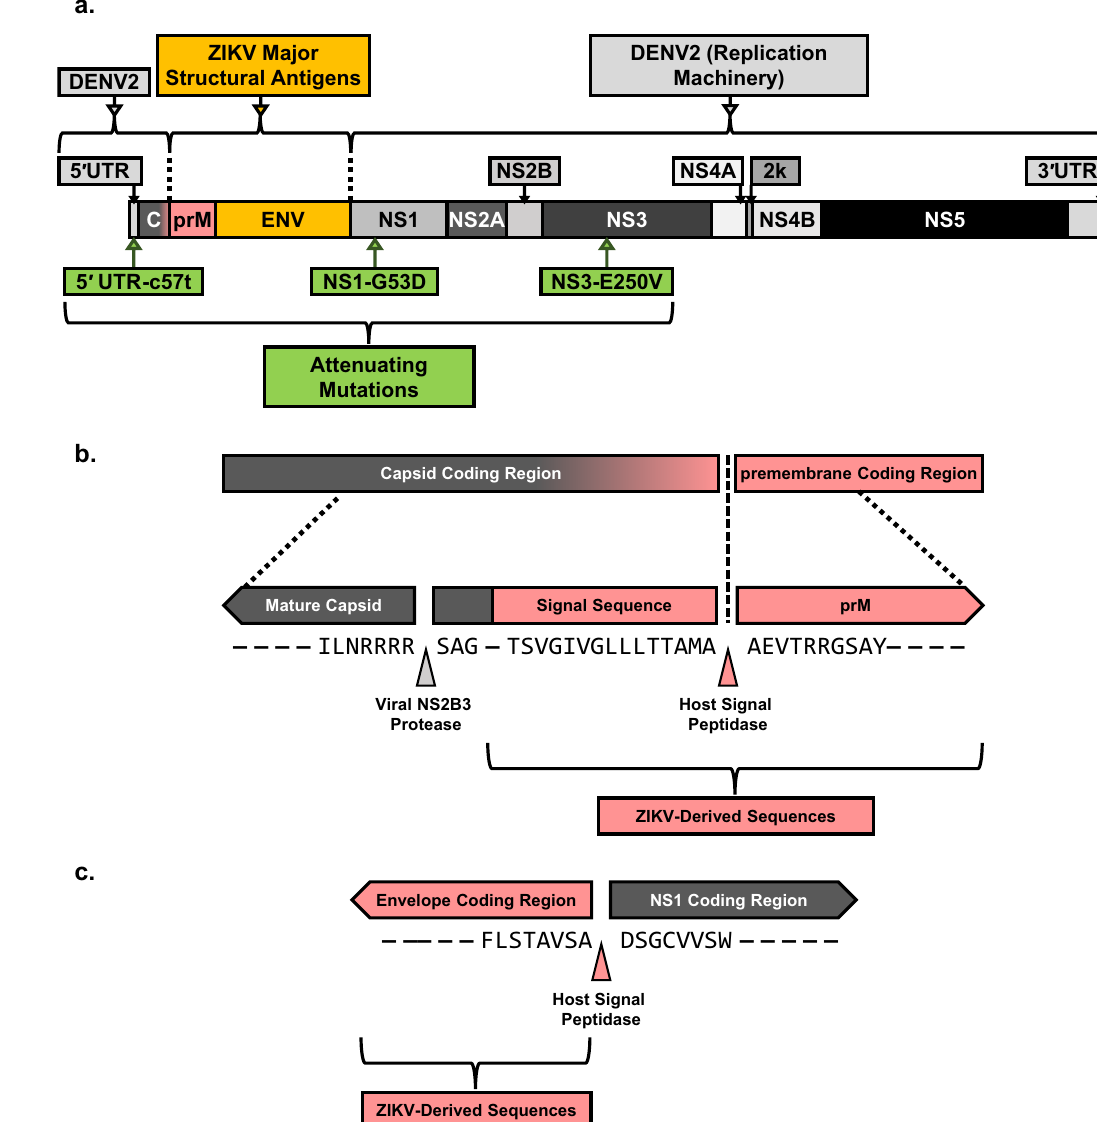
Fig. 1 Genomic map and signal sequences of chimeric Zika/dengue virus VacDZ. a Genomic map of VacDZ. 5 ′ & 3 ′ UTR: untranslated regions. Protein coding regions: C, capsid protein; prM, premembrane protein; Env, envelope protein; NS1 to NS5, non-structural proteins 1 to 5. ZIKV-PRVABC59 derived sequences are shown in red and gold. b Premembrane protein signal sequence at the capsid-premembrane junction. The C-terminus of the capsid protein contains the premembrane signal sequence, and in VacDZ this signal sequence is ZIKV derived. Grey and red triangles indicate cleavage sites of viral NS2B3 protease and host signal peptidase respectively. c Signal sequence at the junction of the Envelope and NS1 proteins. Red triangle indicates cleavage site of host signal